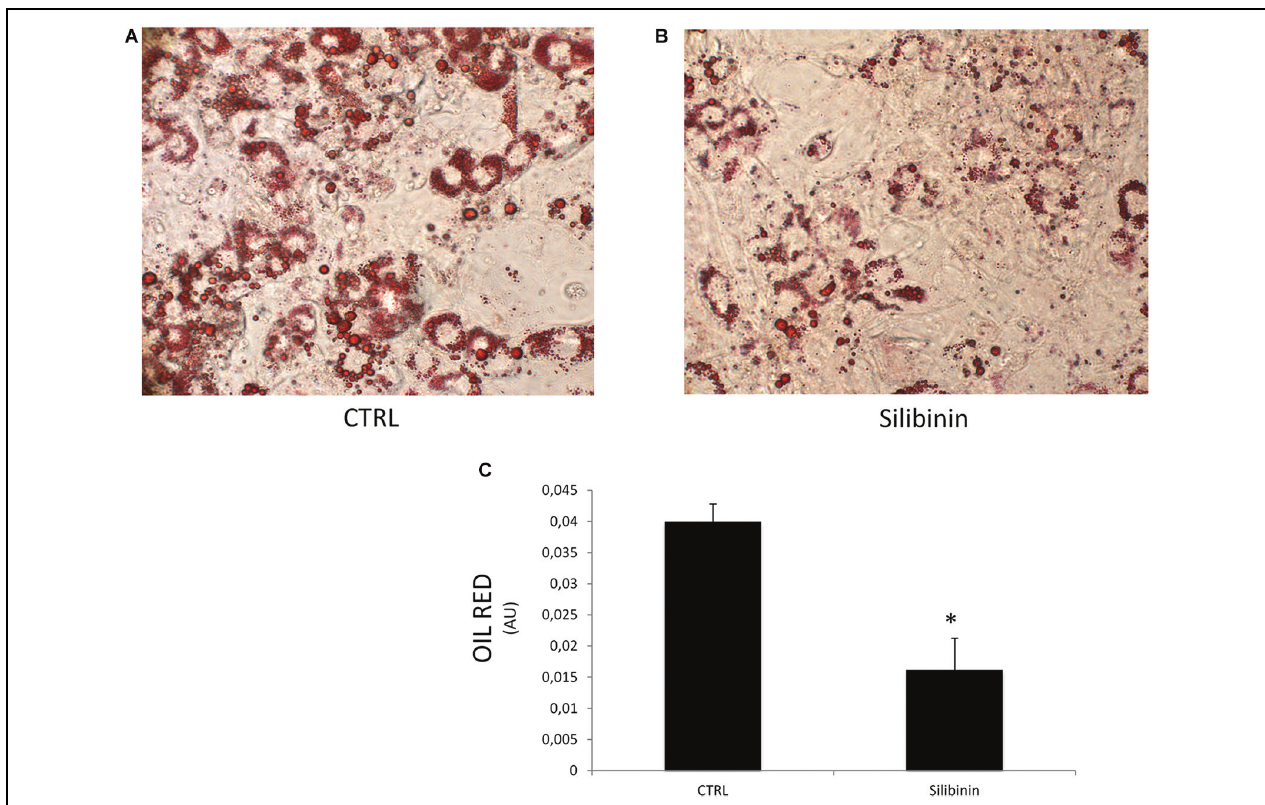
FIGURE 4 | Lipid droplets accumulation measured by Oil red staining in differentiated cells CTRL (A) and in differentiated cells treated for 24 h with silibinin (B). Oil Red staining measured by spectrophotometer ( λ = 490 nm) in differentiated cells and after silibinin treatment (C) . All values are expressed as mean ± SEM of four experiments ( n = 4) in duplicate. ∗ P < 0.05 vs.